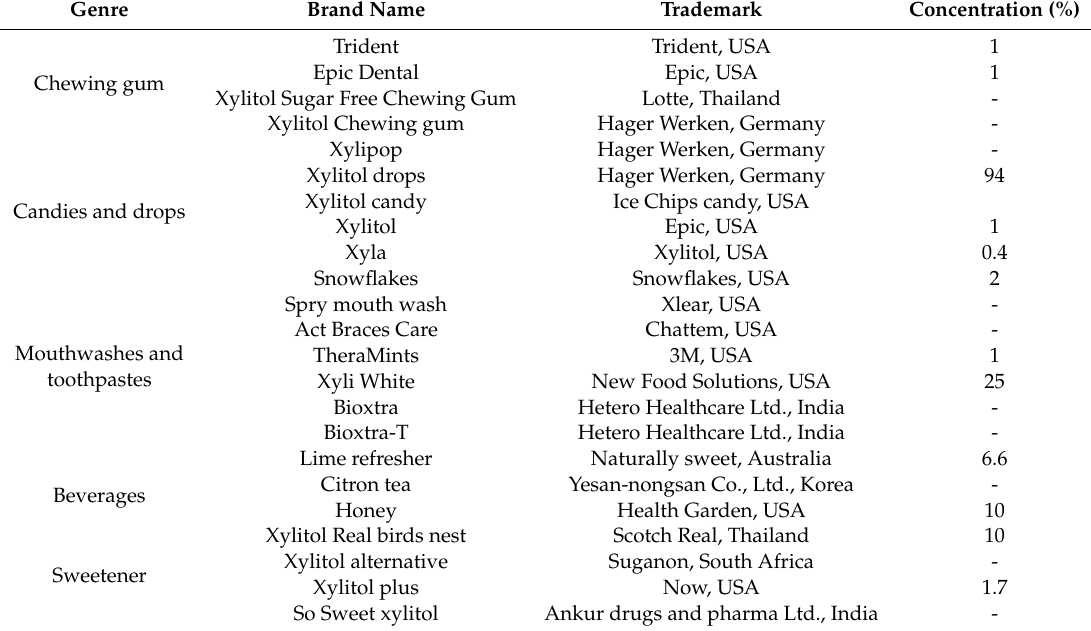
Table 6. Xylitol based commercial products in food industry. The concentration of xylitol (%) used in the products are also